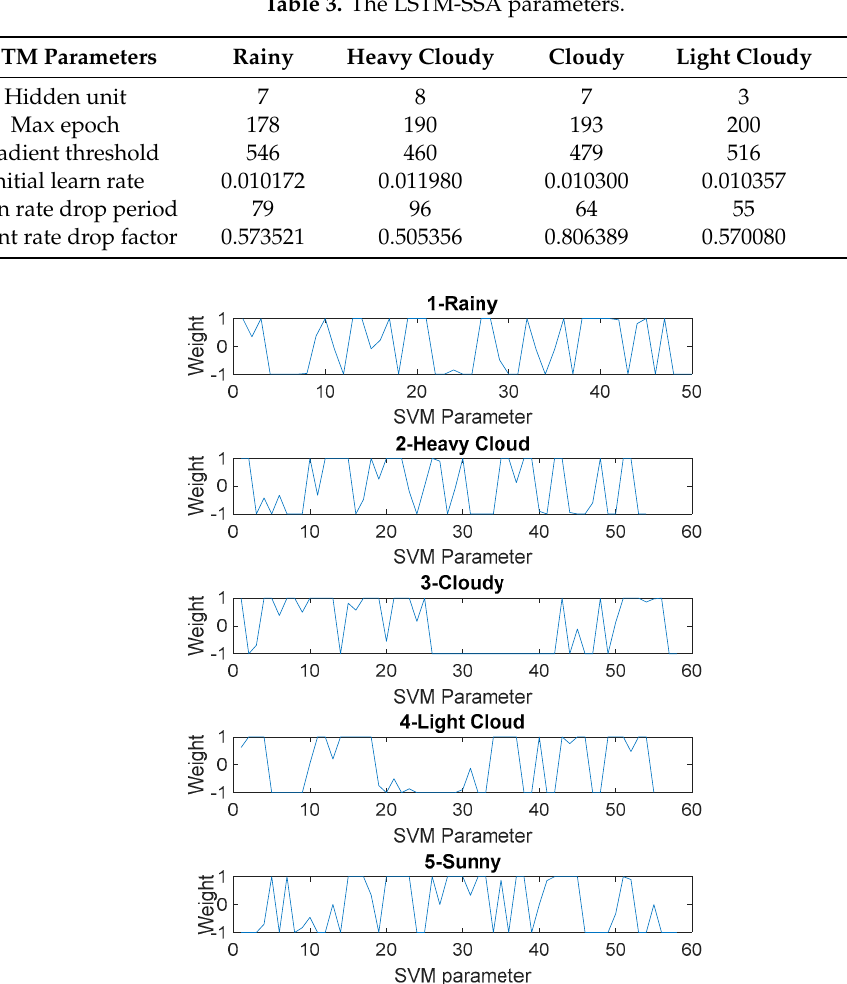
Figure 9. Weights 𝛼 for the support vector machine (SVM)-SSA. Figure 9. Weights α for the support vector machine